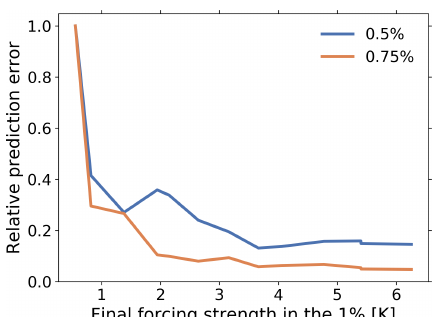
Figure 3. Relative prediction error (Eq. 10) for the 0.5% and 0.75% rad experiments using χ γ (t) recovered from the 1% rad experi- ment. The error is shown as function of the final forcing strength used for the recovery of χ γ (t) . No clear minimum is found, so that the recovery seems not to be limited by